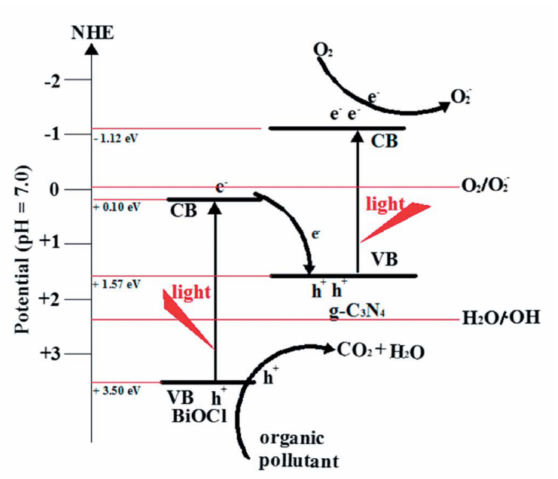
Figure 11. Direct Z-scheme photocatalytic mechanism of BiOCl/g-C 3 N 4 . Reproduced with permis- sion from Bai Y et al, RSC Advances; published by Royal Society of Chemistry,